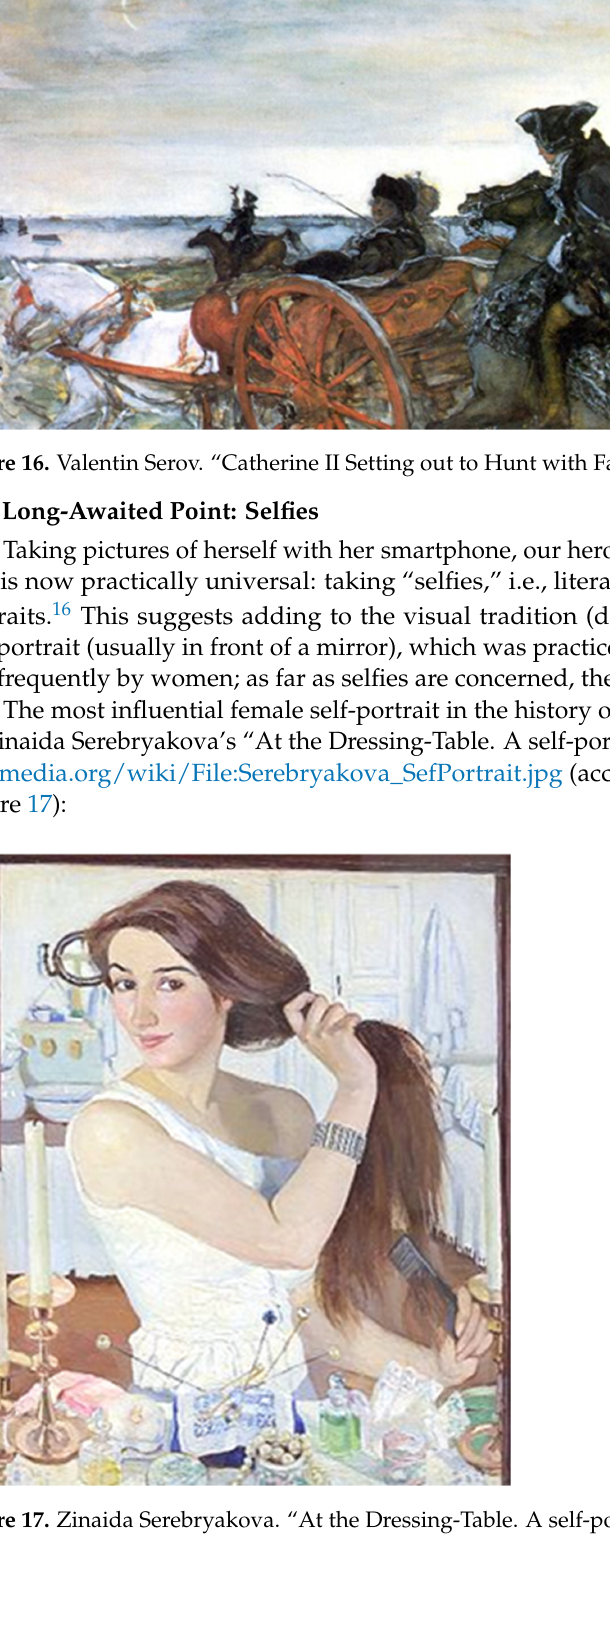
Figure 17. Zinaida Serebryakova. “At the Dressing-Table. A self-portrait” (1909).